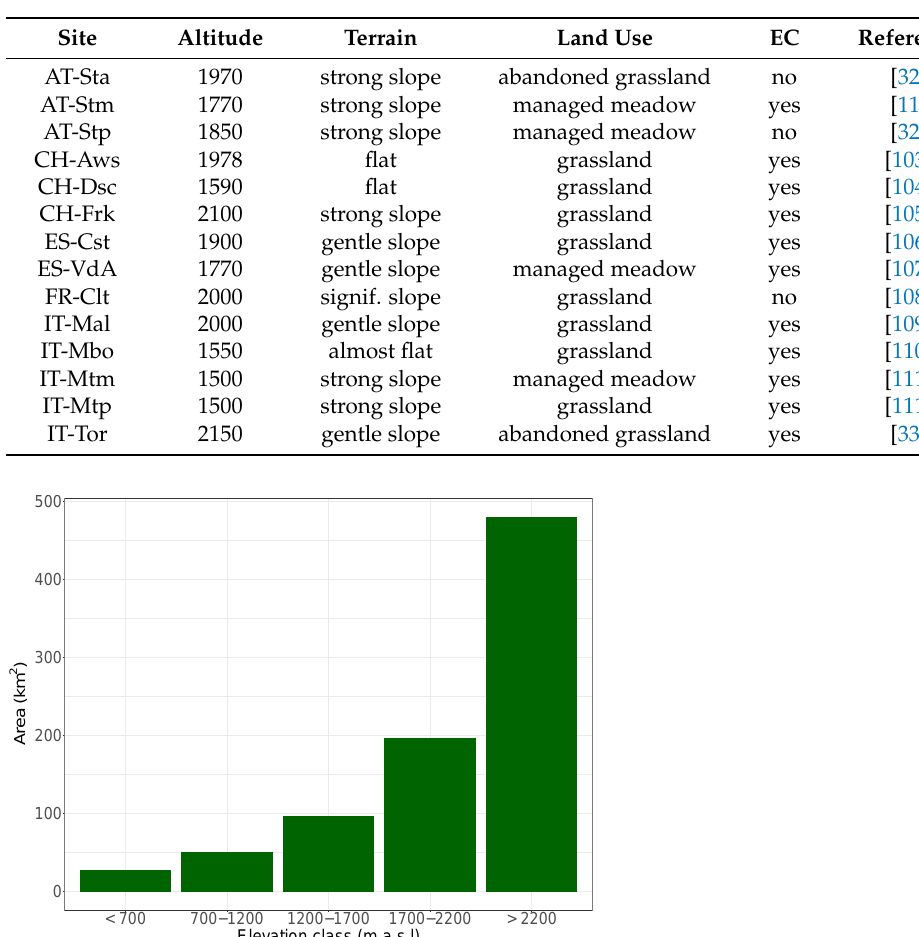
Figure A1. Number of grassland stations in Europe. The blue bar indicates the altitude range in which the Cogne site is located. Table A1. Main experimental mountain sites on Alpine grasslands (Alps) and their characteristics.